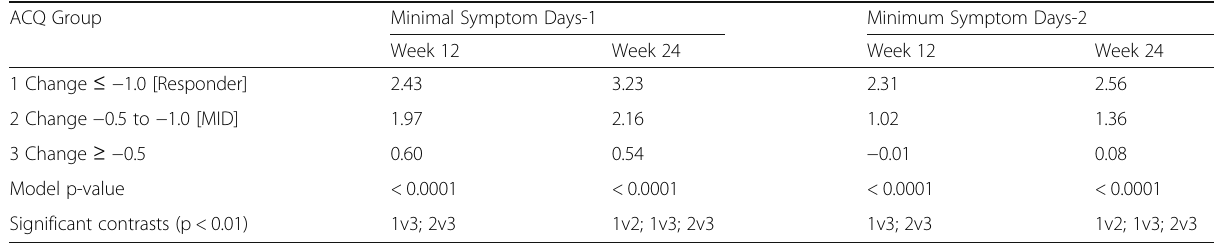
Table 6 Changes in ASD Minimal Symptom Days in a 7-Day Period by ACQ Change Groups at Weeks 12 and 24 ACQ Group Minimal Symptom